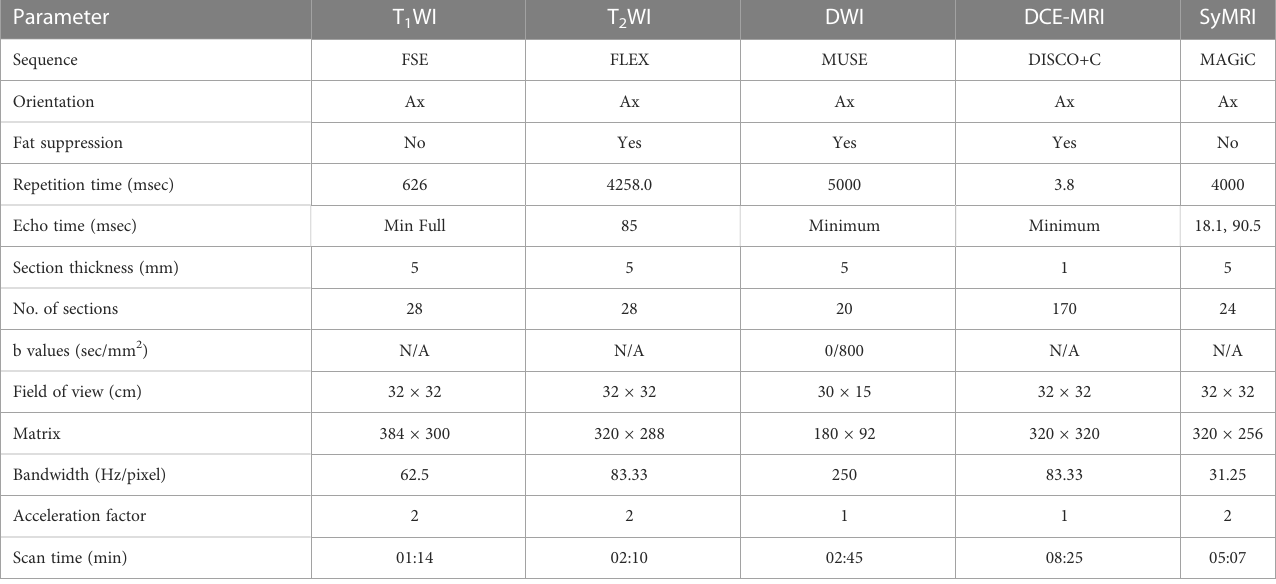
TABLE 2 Imaging protocols for MRI.